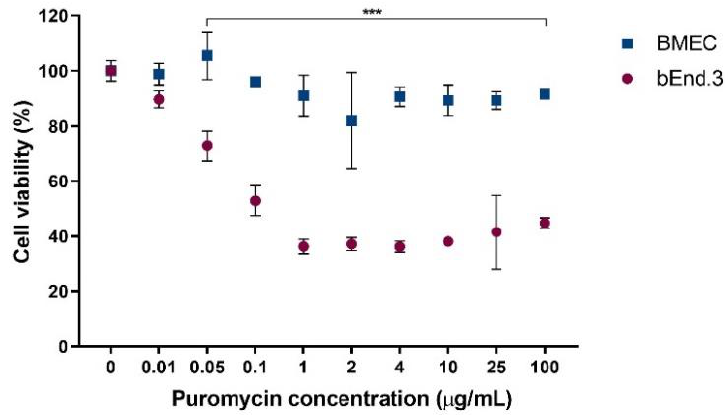
Figure 2. Effect of puromycin on BMEC (blue) and bEnd.3 cell (red) viability. Data were analyzed using a 2-way ANOVA test (**** p < 0.0001). Points represent the average cell viability ± SD ( n = 6).